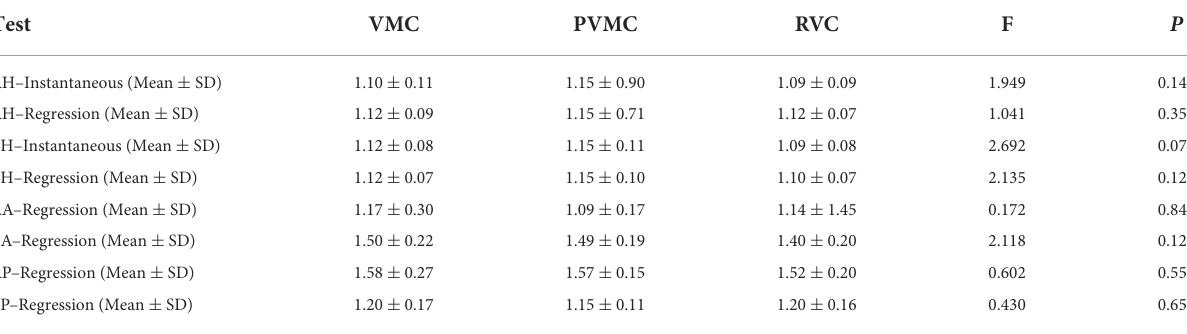
TABLE 4 Characteristics of VOR gains induced by vHIT.